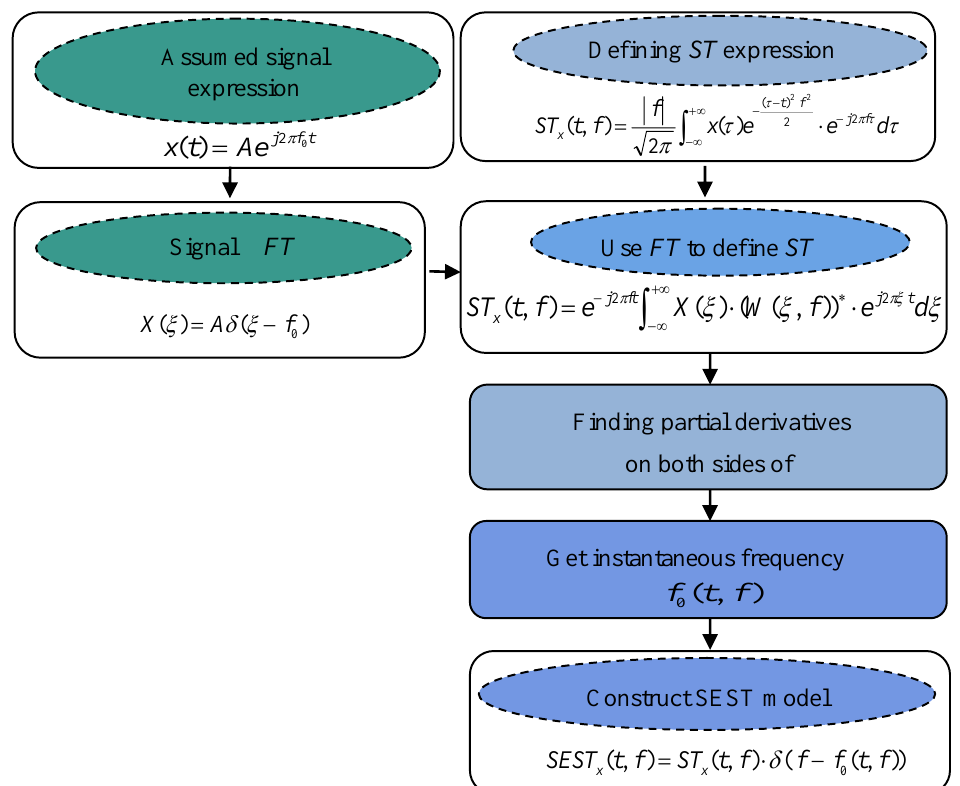
Figure 1. Algorithm flow chart of harmonic signal SEST.